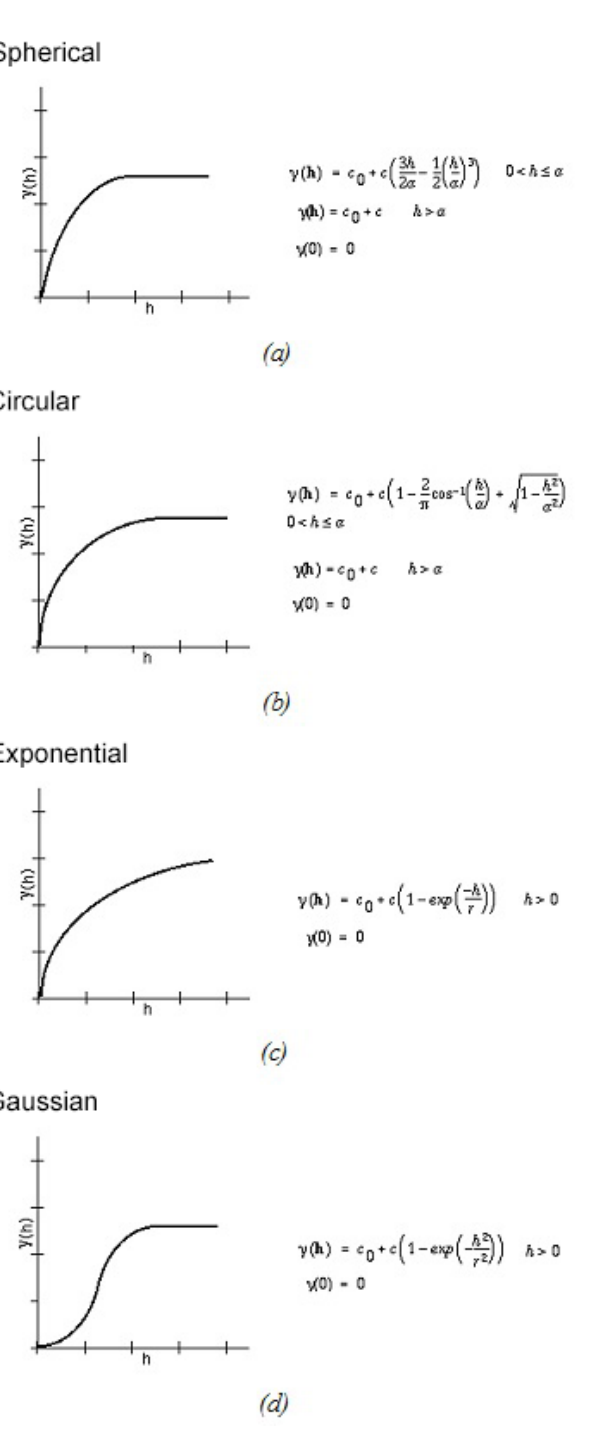
Figure 3. Semivariogram graphs: (a) spherical; (b) circular; (c) ex- ponential; (d) Gaussian.